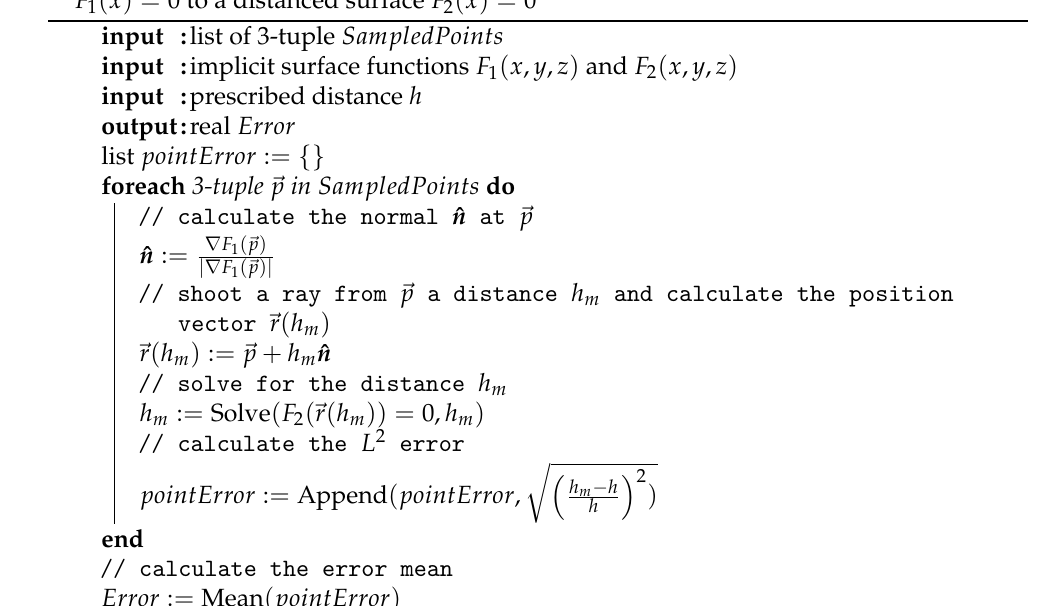
Algorithm 2: Calculation of the L 2 error in distance h from points in the